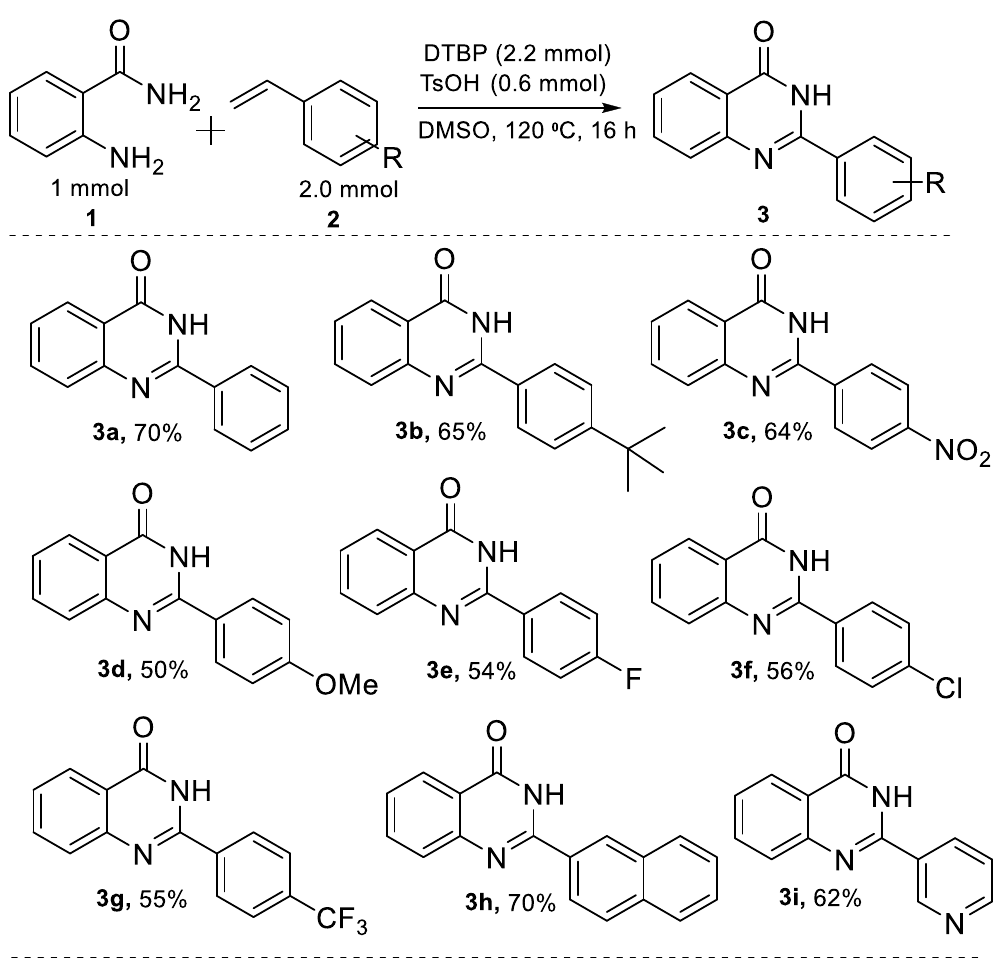
Figure 3. Synthesis of quinazolin-4(3 H )-one: substrate scope a.